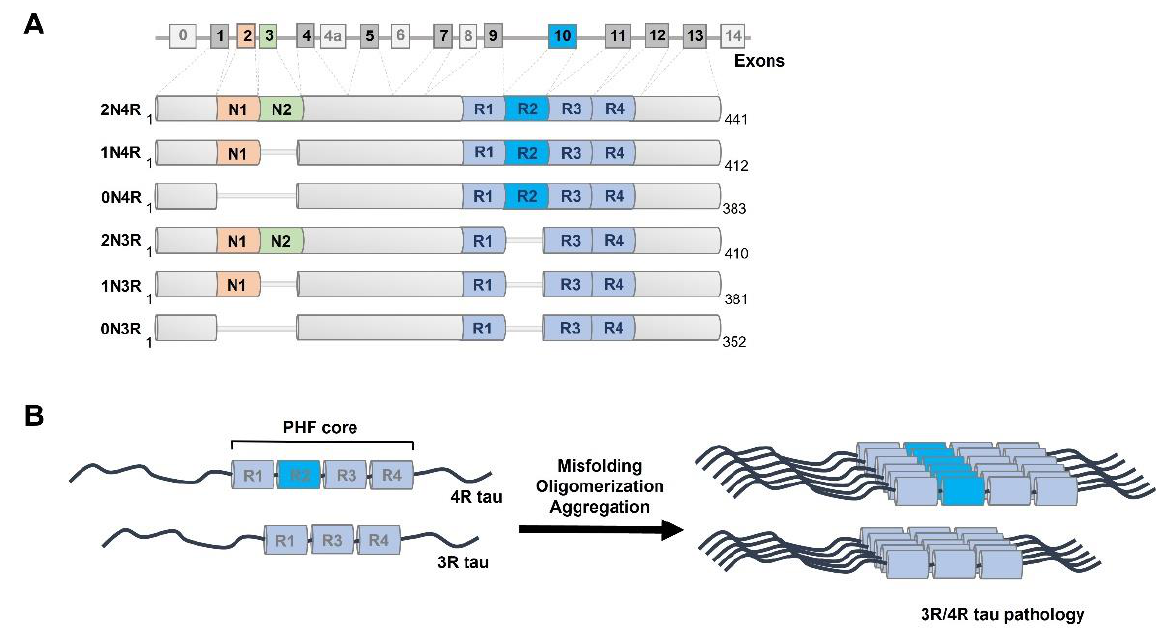
Figure 1. Alternative splicing of MAPT gene and tau protein aggregation. ( A ) Alternative splicing of exons 2, 3, and 10 leads to six isoforms of tau in the adult human brain; exons 4A, 6, and 8 are exclusive to the peripheral nervous system and absent in the human brain [104]. Six isoforms of human tau occurring in the central nervous system (2N4R, 1N4R, 0N4R, 2N3R, 1N3R, 0N3R) vary by the presence or absence of N-terminal regions (N1, N2) and repeat domain 2 (R2), resulting in molecular weights ranging from 36,760 Da (0N3R) to 45,850 Da (2N4R). ( B ) Tau is under physiological conditions an intrinsically disordered protein that dynamically interacts with and stabilizes microtubules. Under pathological conditions, tau repeat region cores undergo conformational transition to beta sheet-rich secondary structures prone to formation of oligomers and paired helical filaments (PHF) [105] with amyloid tinctorial properties.